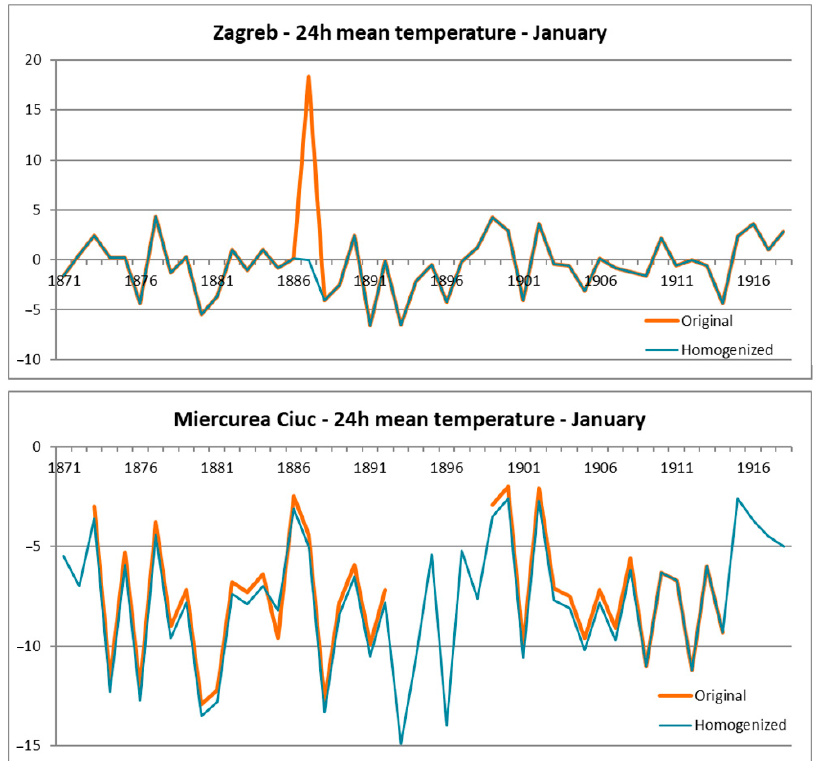
Figure 2. January monthly means of 24 h temperature before and after MASH homogenization for Zagreb ( upper ) and Miercurea Ciuc ( bottom ).